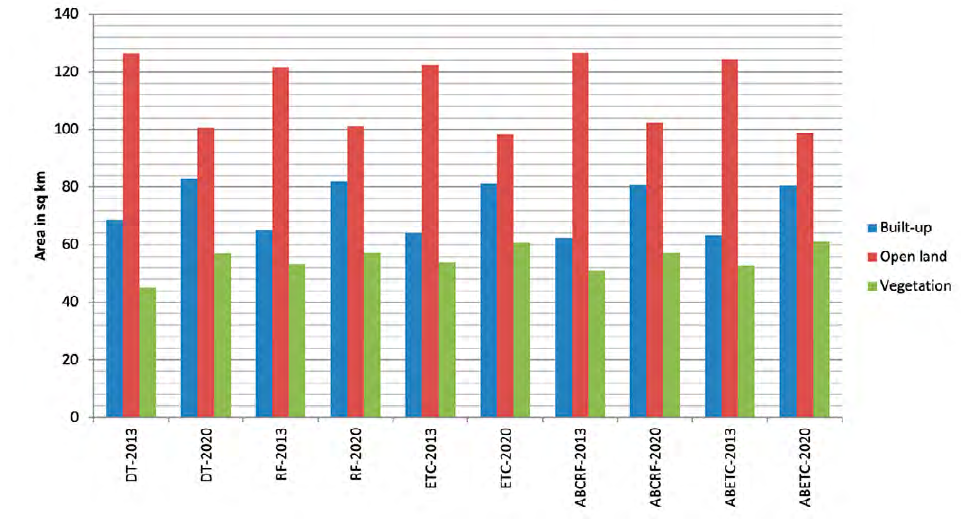
Figure 9. Area comparison graph of Vadodara data sets